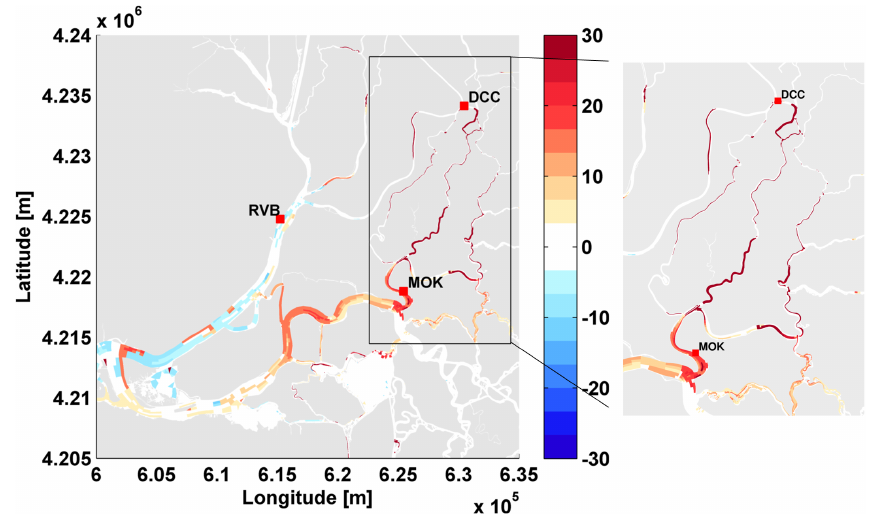
Figure 7. Anomaly of a SSC (mgL − 1 ) snapshot between runs with open–closed DCC. This pattern is representative in time as well. The right panel is a detailed box between the DCC and MOK (black rectangle). Red shades represent regions where the SSC level is higher in the open than the close scenario, the blue shades where it was lower.